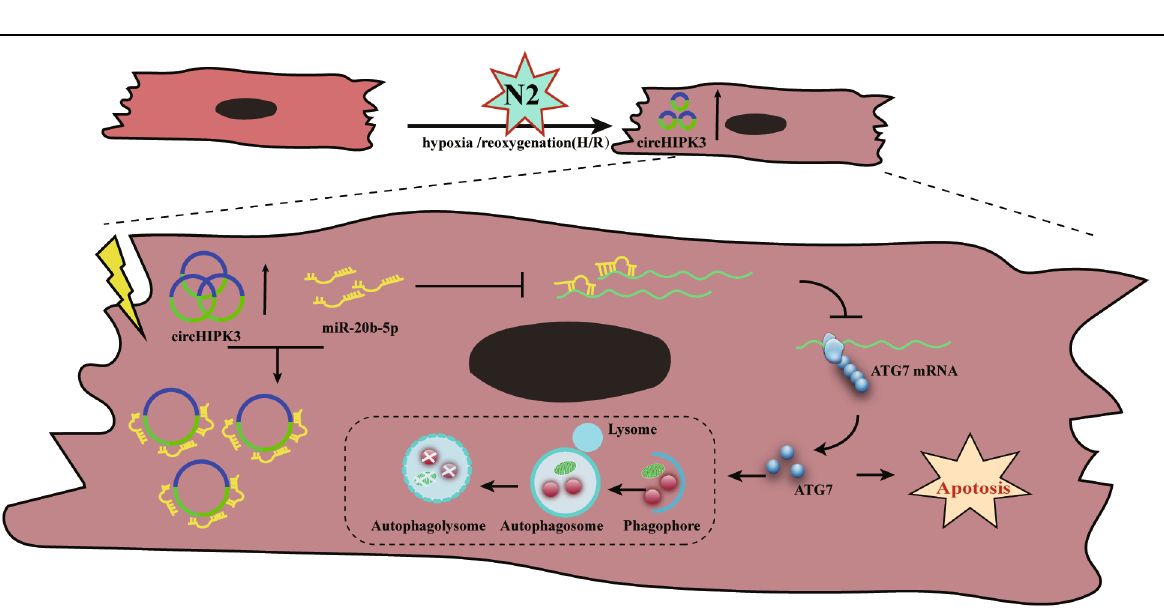
Fig. 6 A schematic diagram of the circHIPK3/miR-20b-5p/ATG7 axis in cardiomyocytes. In H/R-stimulated cardiomyocytes, circHIPK3 sponges endogenous miR-20b-5p to sequester and inhibit the activity of miR-20b-5p, which leads to increased expression of ATG7, thereby regulating the autophagy and apoptosis of